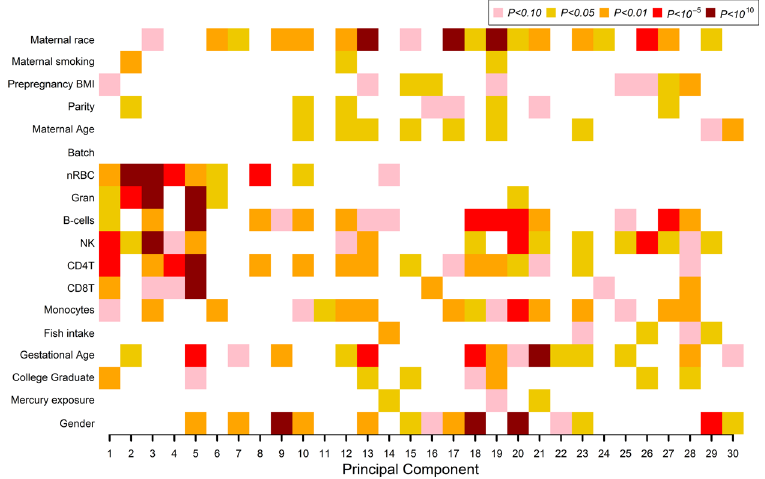
Figure 1. Principal component regression analysis: univariate association P -values between covariates of interest and the top 30 principal components that explain 51.4% of the variance for the entire DNA methylation data in cord